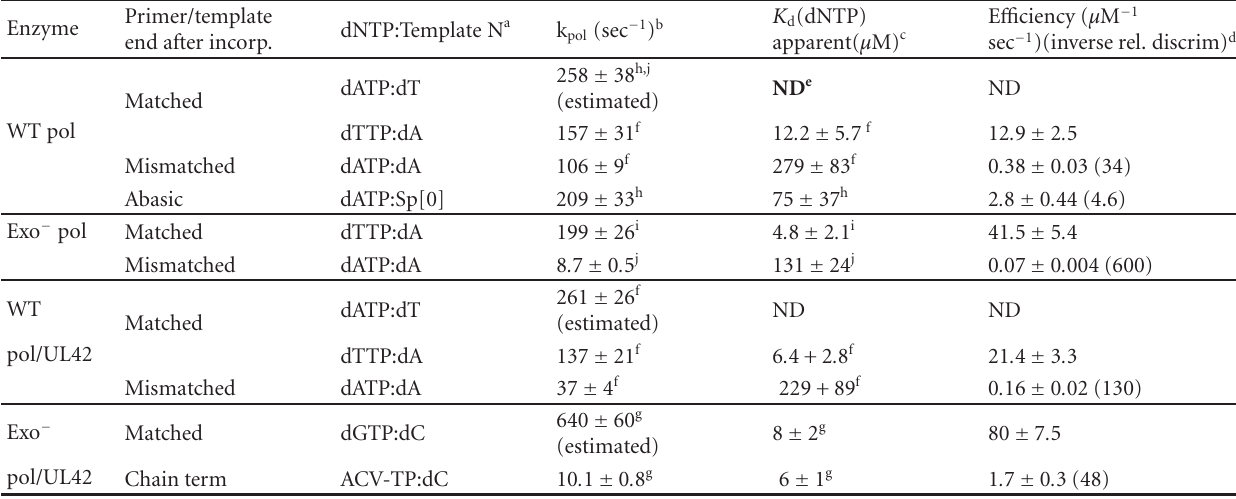
Table 1: Summary of presteady-state kinetics of nucleotide incorporation by HSV-1 DNA polymerase. Enzyme